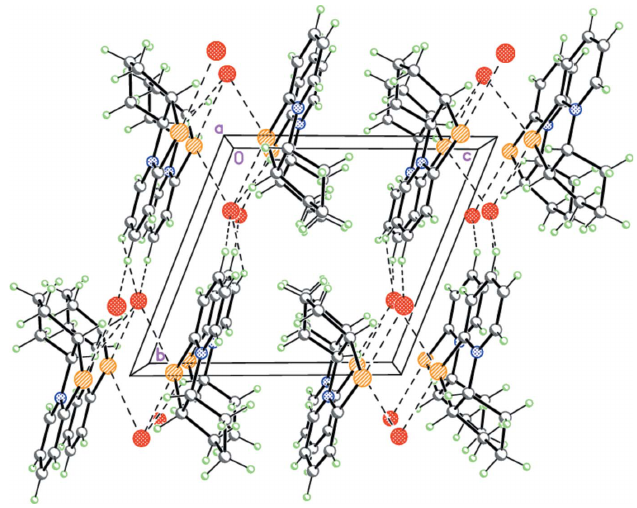
Figure 9 Crystal structure of 2 showing the double layers parallel to (001). Dashed lines indicate the intermolecular C—H (cid:3)(cid:3)(cid:3) Br hydrogen bonds as well as the non-covalent Se (cid:3)(cid:3)(cid:3) Br